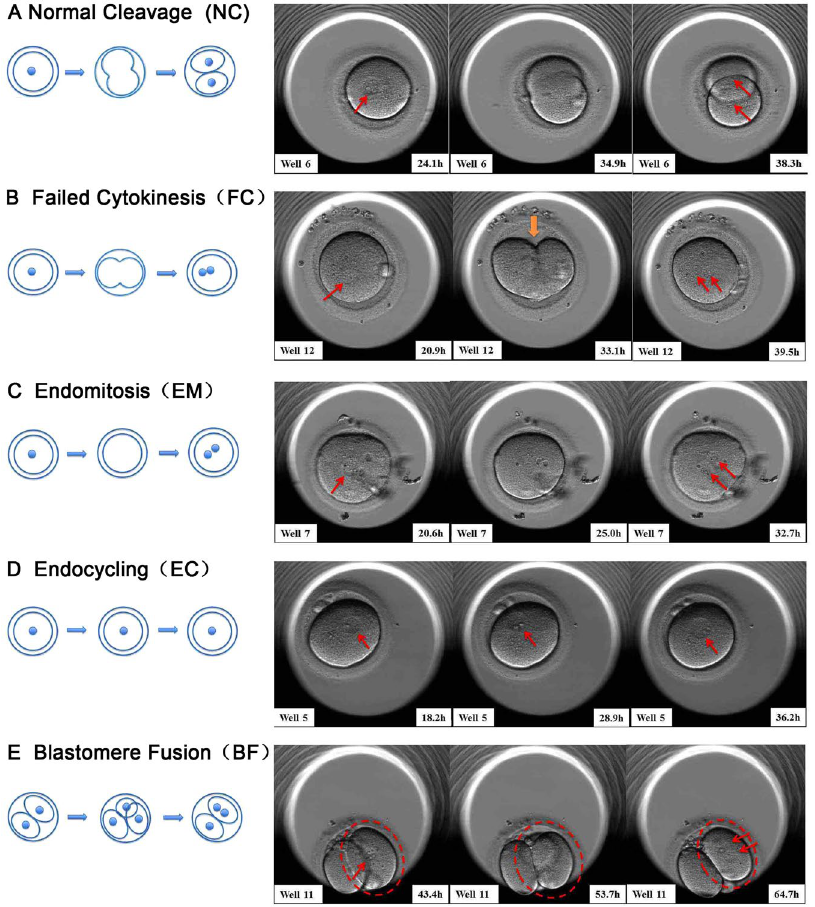
Figure 1. Normal and four kinds of self-diploidization-related cleavage behaviours were recorded by time- lapse photography in haploid parthenotes (HPs). ( A ) Normal cleavage (NC), cleavage from one cell to two even blastomeres; ( B ) Failed cytokinesis (FC), a cleavage furrow appeared but the cell recovered into one cell again rather than divide into two daughter blastomeres; ( C ) Endomitosis (EM), replication of the nucleus was complete, but there was no appearance of the cleavage furrow; ( D ) Endocycling (EC), the duration of the pronuclear phase was extended obviously and more than one cell cycle occurred; and ( E ) Blastomere fusion (BF), one cell divided into two daughter blastomeres, which fuse into one blastomere again after a mitotic cycle. The nucleus is indicated by a red